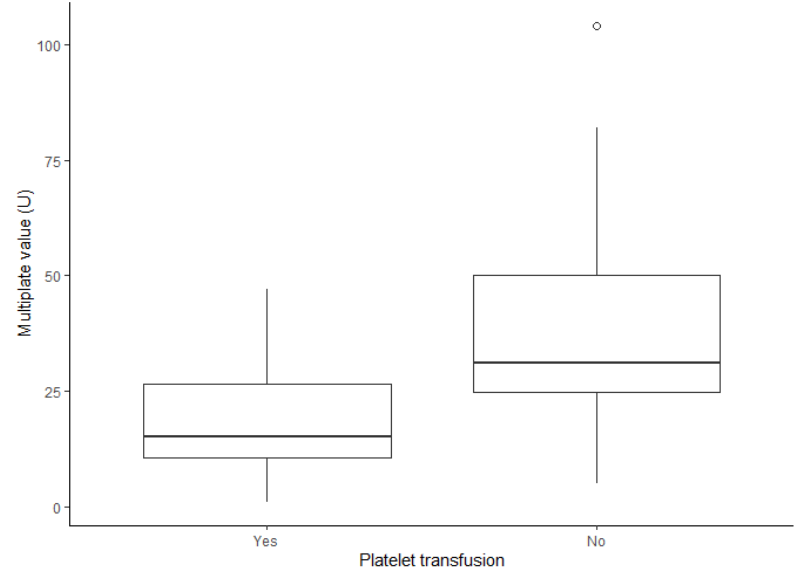
Figure 3. Last preoperative ADP–MEA result according to perioperative platelet transfusion status. Patients with perioperative platelet transfusion had a mean preoperative ADP–MEA value significantly lower than patients without ( p = 0.03). Boxes represent interquartile ranges, central line represents the median, and whiskers represent the minimum–maximum range, excluding one outlier value, represented as a circle.